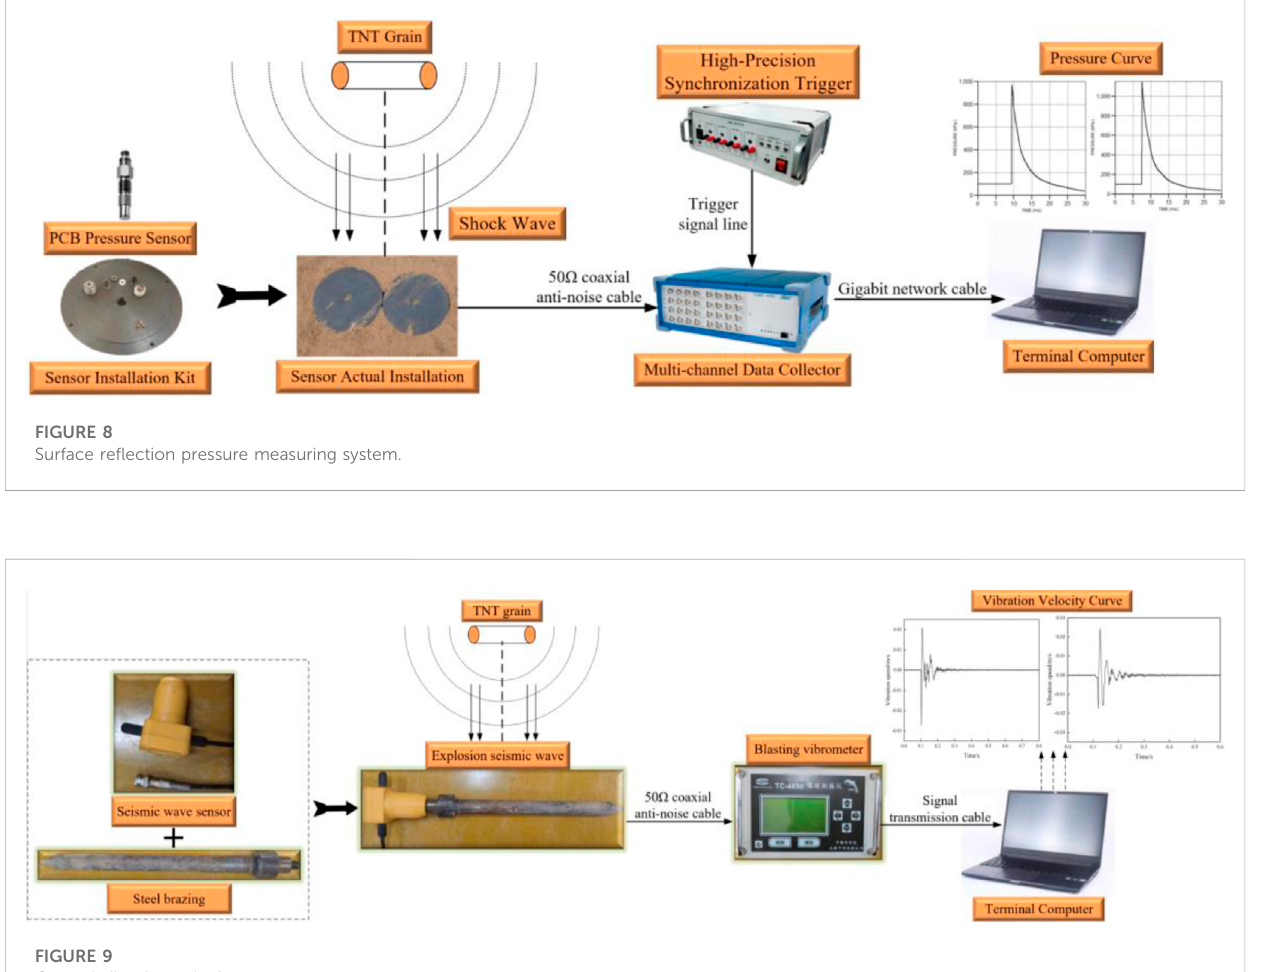
FIGURE 9 Ground vibration velocity measurement system.